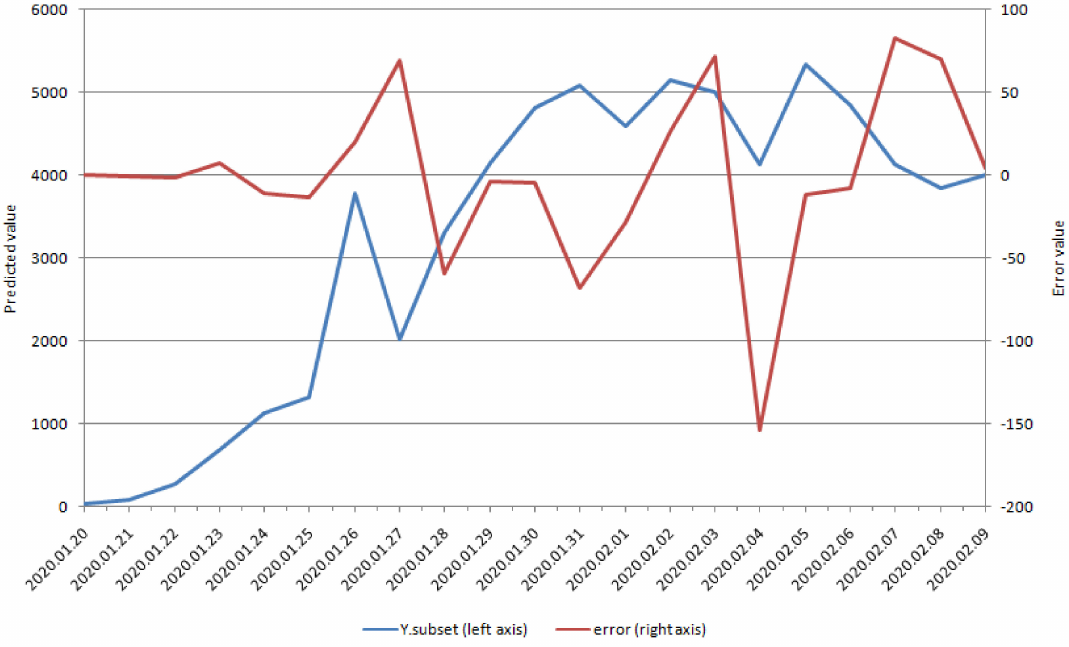
Figure 3. The prediction by subset selection and the error term.